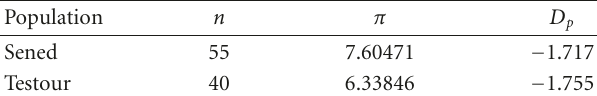
Table 5: Characteristics of the studied populations.